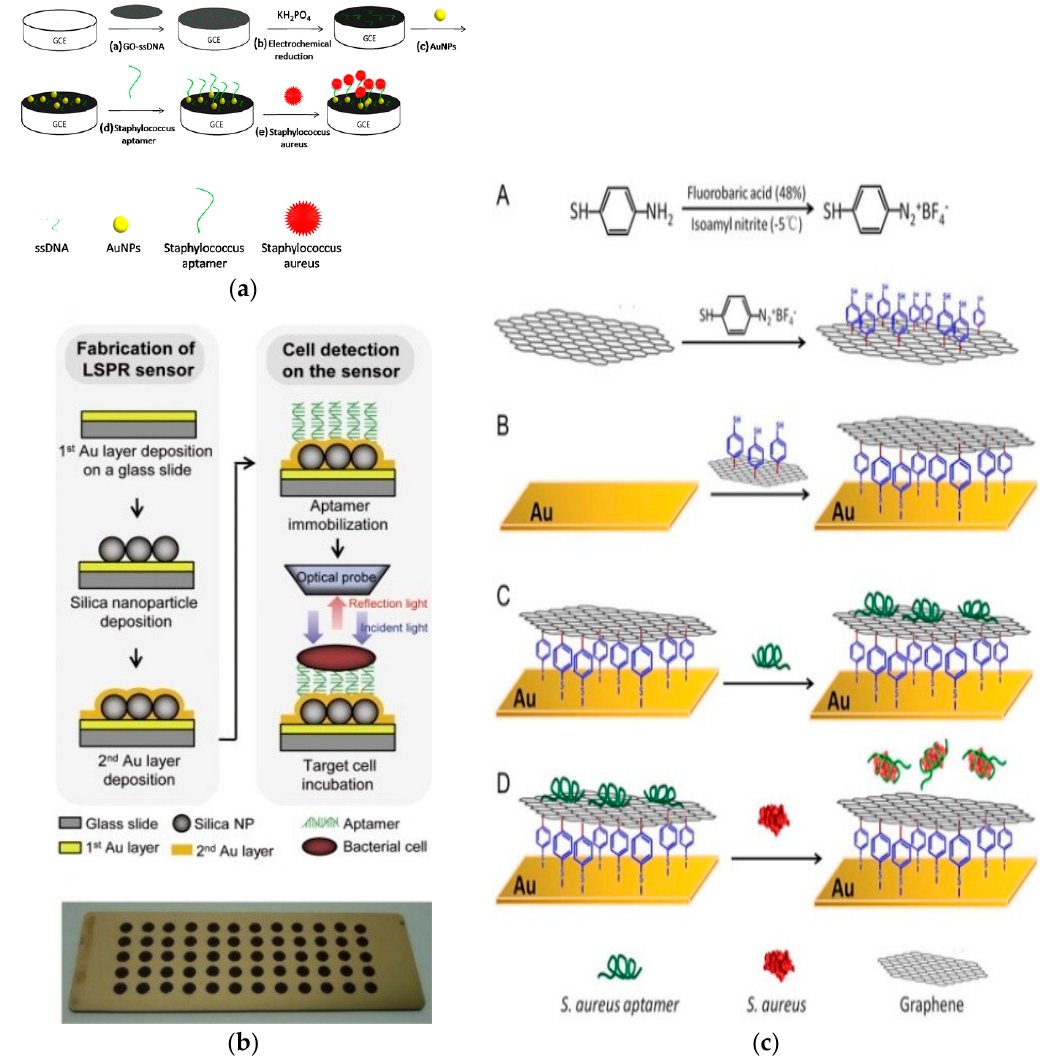
Figure 3. ( a ) Schematic representation of the principle of impedance-based detection of S. aureus on a GCE-rGO-ssDNA-AuNPs-aptamer nanocomposite (adapted with permission from [37]); ( b ) Aptamer based multispot gold-capped NPs array (MG-NPA) chip containing a dielectric layer of a thin gold (Au) layer on silica (Si) NPs-absorbed glass slide (adapted with permission from [42]); ( c ) Measurements of S. aureuse on Au surface functionalized with grahene and aptamer with modification steps: ( A ) immobilization of mercaptobenzenediazonium tetrafluoroborate (MBDT) on grapheme; ( B ) Immobilization of graphene on Au; ( C ) immobilization of aptamer and ( D ) detachment of aptamers from graphene in the presence of S. aureus (adapted with permission from [38]).